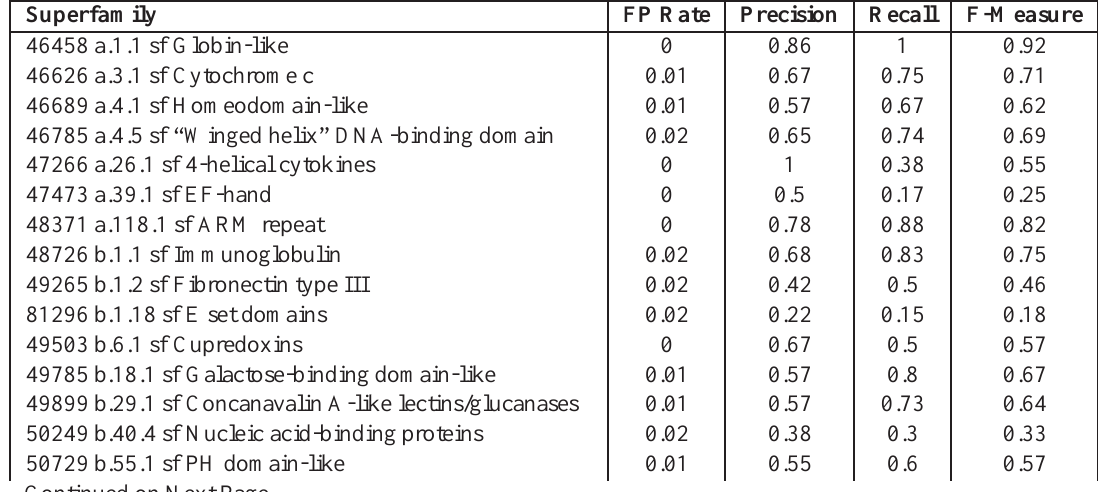
Table 5: Performance in prediction of each of 49 SCOP superfamilies (analysis that included multi domain proteins) studied using AdaBoostM1 with enrichment at a redundancy cutoff of 30% (FP=False